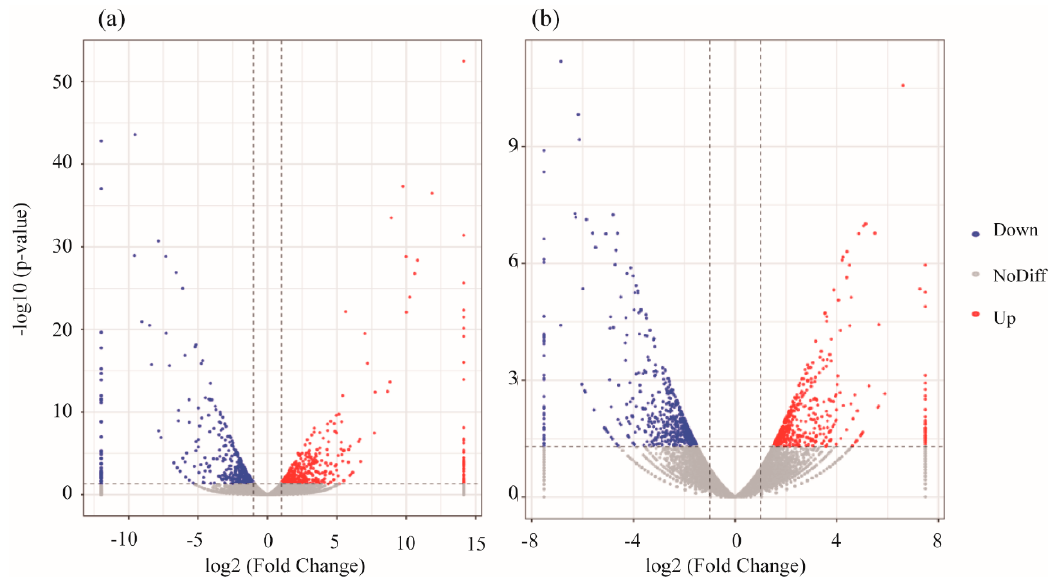
Figure 6. Volcano plots of the gene libraries of heads from experimental fish in the antibiotic-treated groups and control group showing the variance in gene expression with respect to FC and FDR. Each dot represents an individual gene: the black dots on the left represent the downregulated genes, and the red dots on the right represent the upregulated genes ( a ) D. rerio , ( b ) O. latipes .